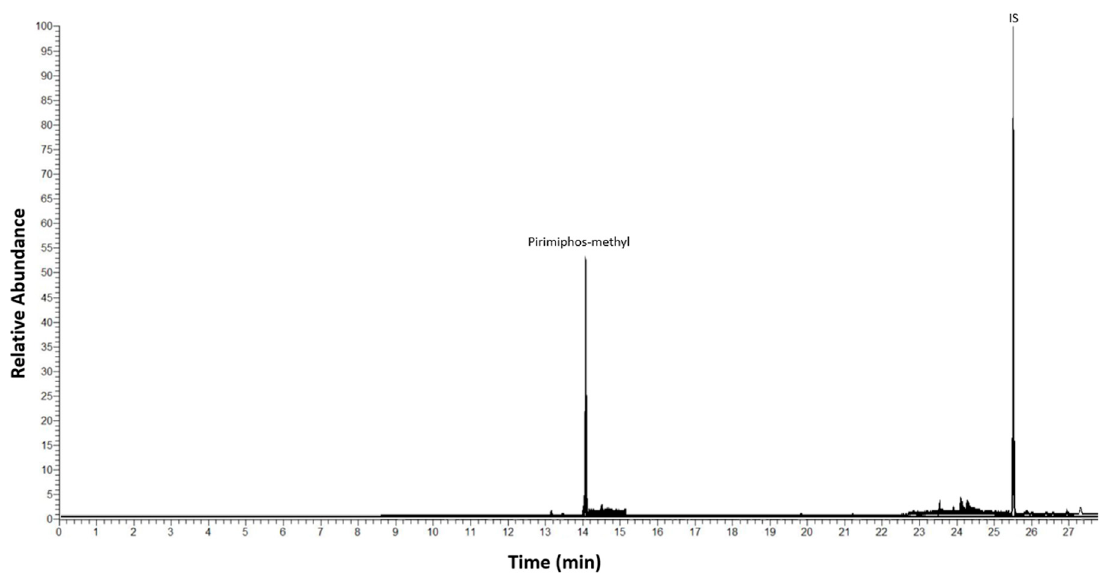
Figure 3. Chromatographic separation of a wheat sample contaminated by pyrimiphos methyl.